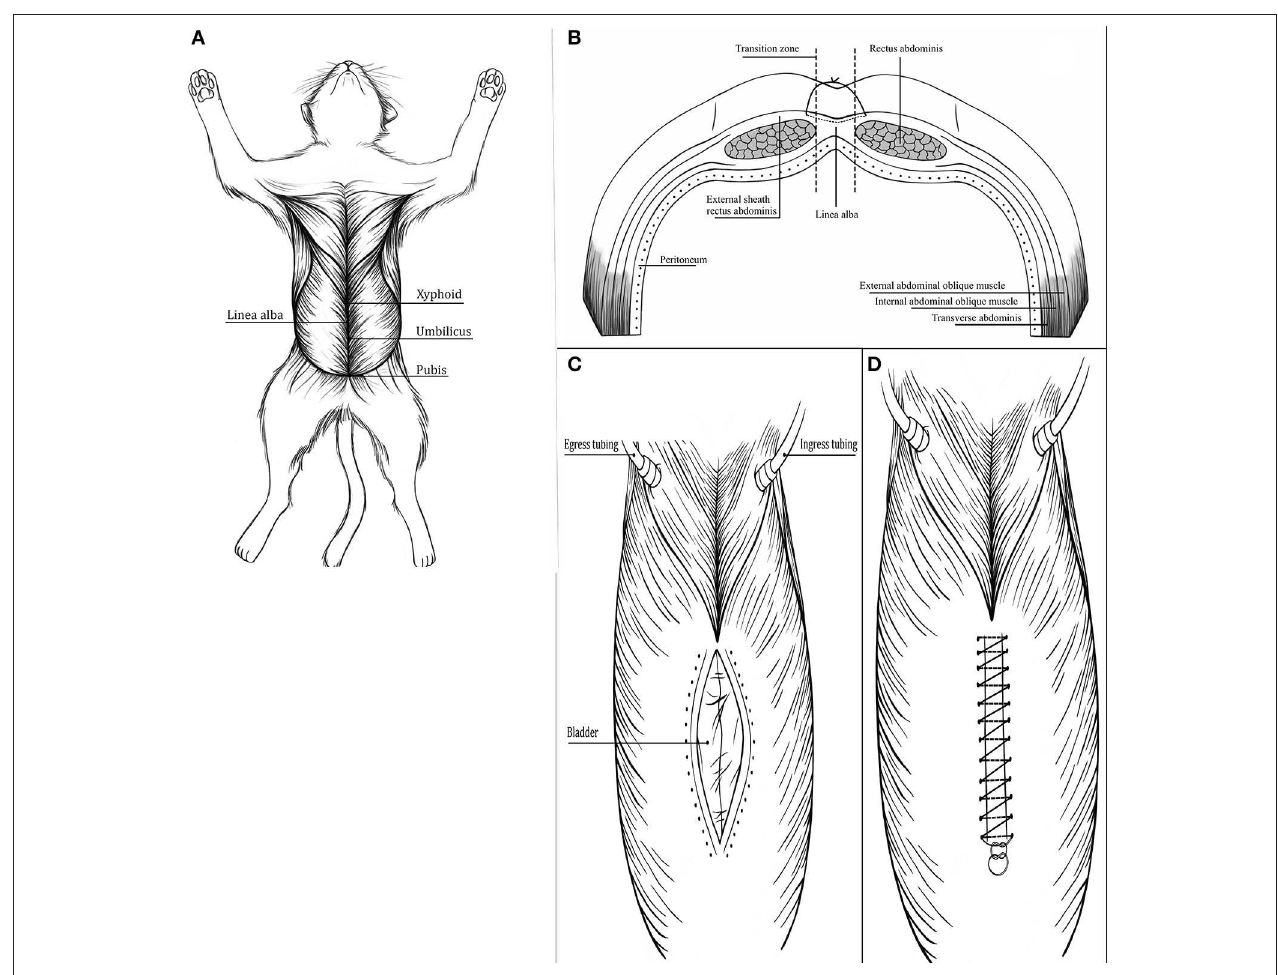
FIGURE 1 | (A) Cat in dorsal recumbency after reflecting the skin and subcutaneous tissue from the xiphoid to the pubis to expose the entire ventral abdominal wall and linea alba. (B) Diagram (transverse view) showing suture placement and layers included in celiotomy closure. (C) Custom made bladder placed in the abdominal cavity after celiotomy and connected to egress and ingress tubes. (D) Celiotomy closure